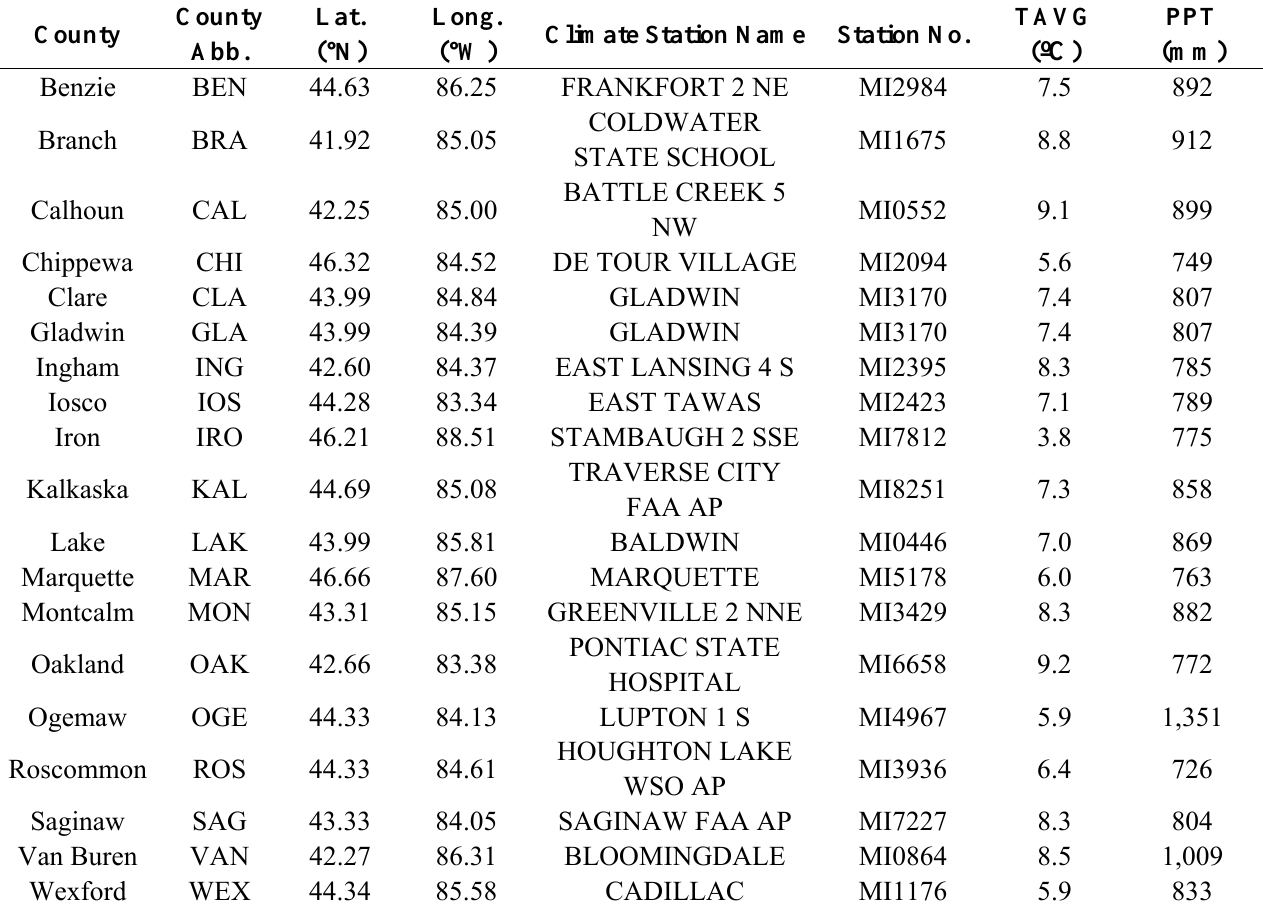
Table 1. Geographical coordinates and climatic conditions for Michigan state county origins (listed in alphabetical order) of aspen parents of hybrid poplar ( Populus × smithii Boivin) for the reference period of 1971–2000 obtained from the National Climatic Data Center [28]. Table abbreviations noted at end of